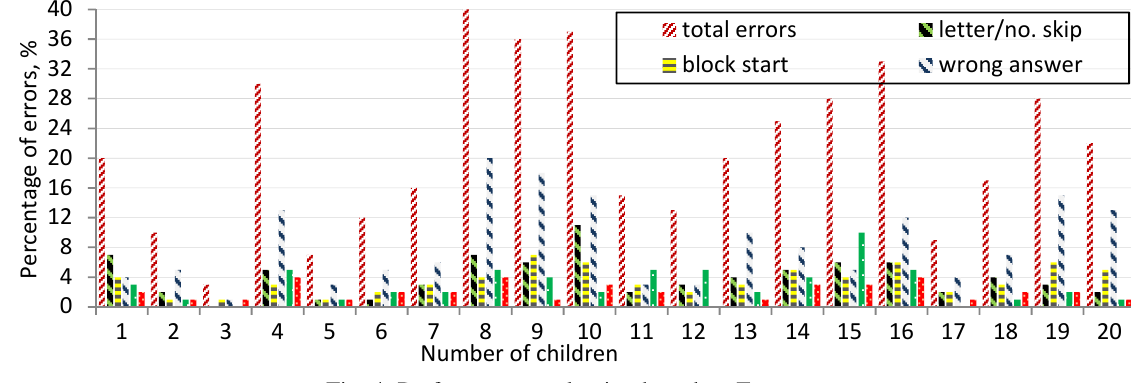
Fig. 4: Performance evaluation based on